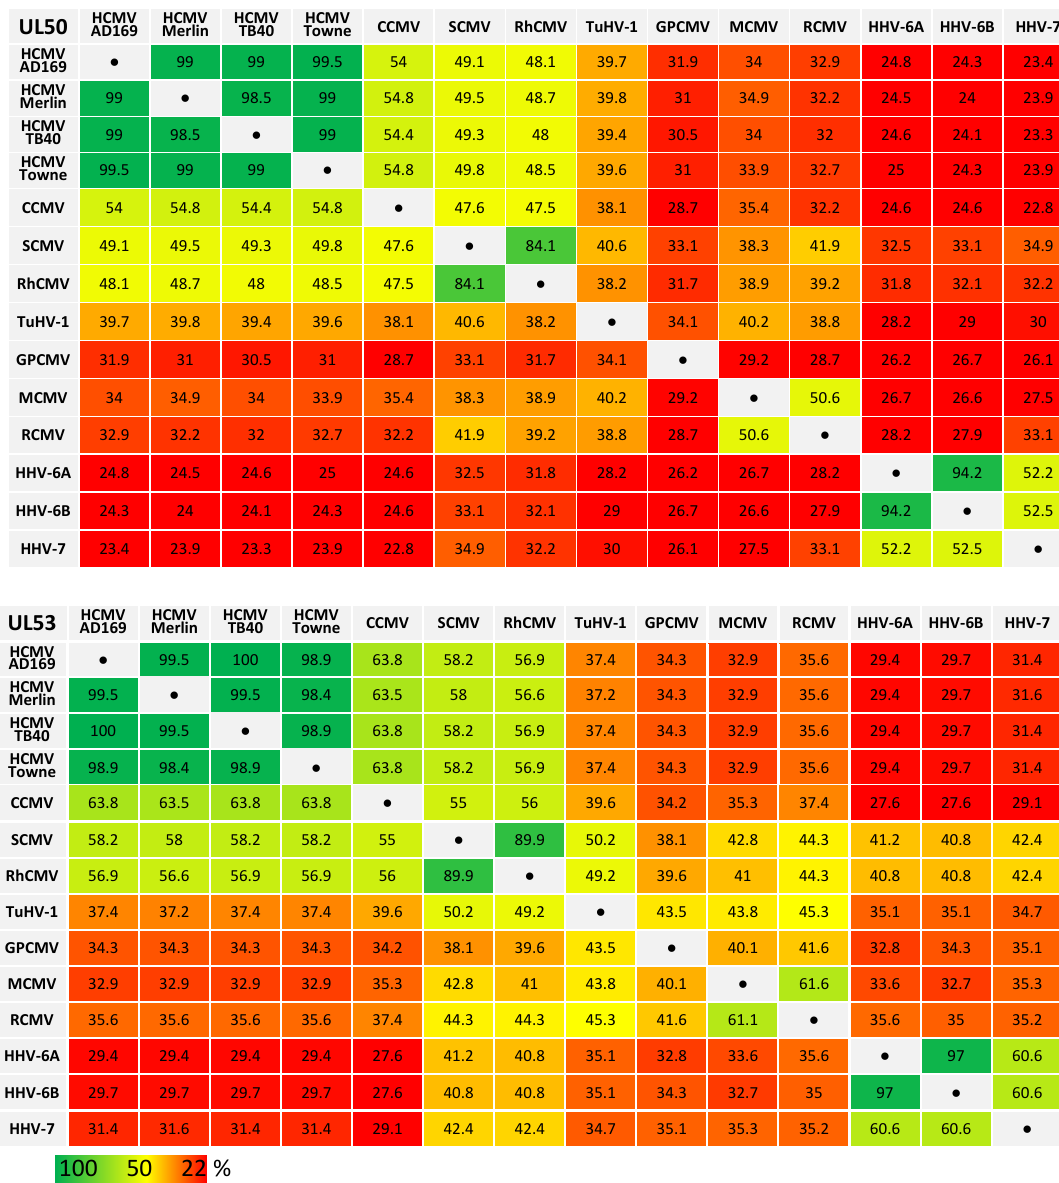
Table 1. Amino acid sequence identities (%) of human and animal β -herpesviral pUL50 and pUL53 homologs